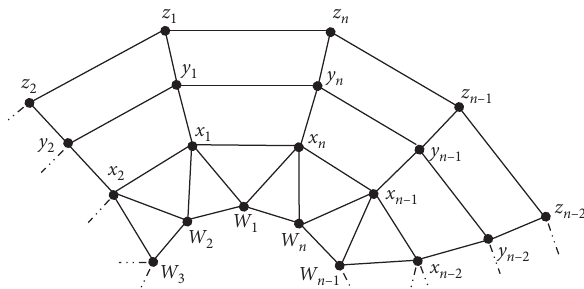
Figure 2: The n -dimensional convex polytope S